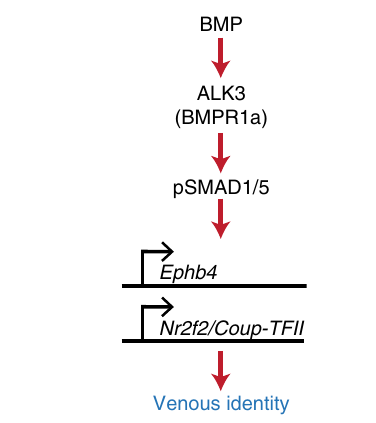
Fig. 10 Proposed model. Our data support a model in which vein-enriched bone morphogenetic protein (BMP) ligands BMP2 and BMP4 signal through the vein-speci fi c Alk3 type I receptor (in combination with multiple different BMP type II receptors) resulting in the phosphorylation of SMAD1/5, transcriptional activation of the Ephb4 and Coup-TFII genes